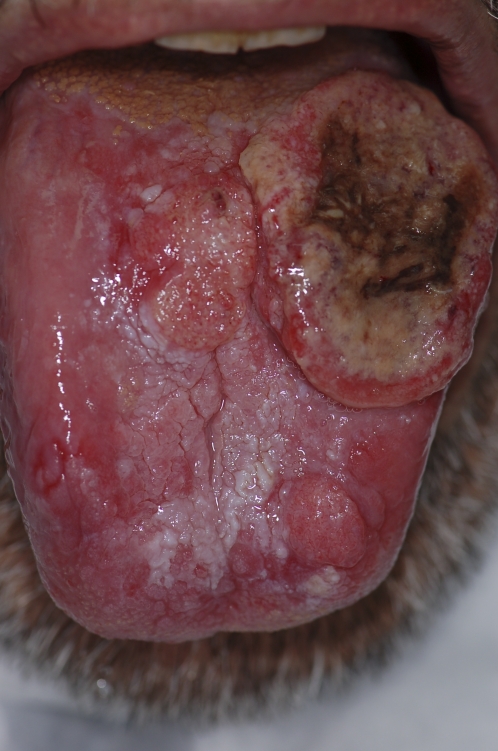
The Dorsum of the Patient's Tonguebreak;On biopsy, the three exophytic masses turned out to be oral carcinomas, while the surrounding hyperkeratotic area showed histologic features of oral lichen planus.